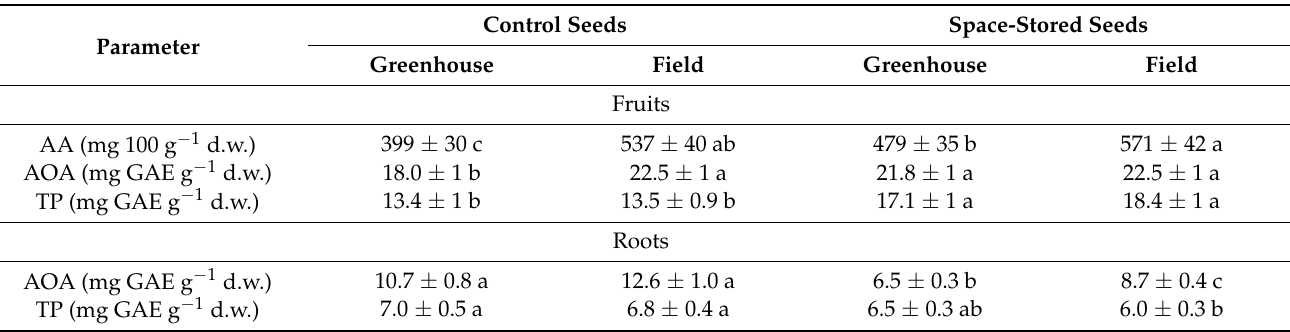
Table 3. Antioxidant compounds and activity of tomato fruits obtained from control and spaceflight-exposed seeds, in greenhouse and in open field.